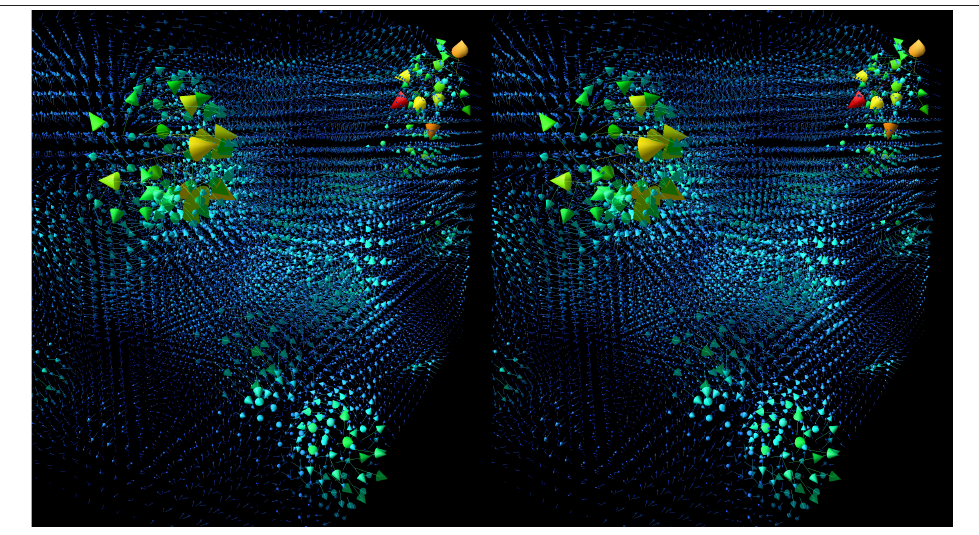
Figure 1. Stereoscopic image of one of the eight chromo-magnetic fields composing the nontrivial vacuum of QCD. Hints for stereoscopic viewing are provided in the text.